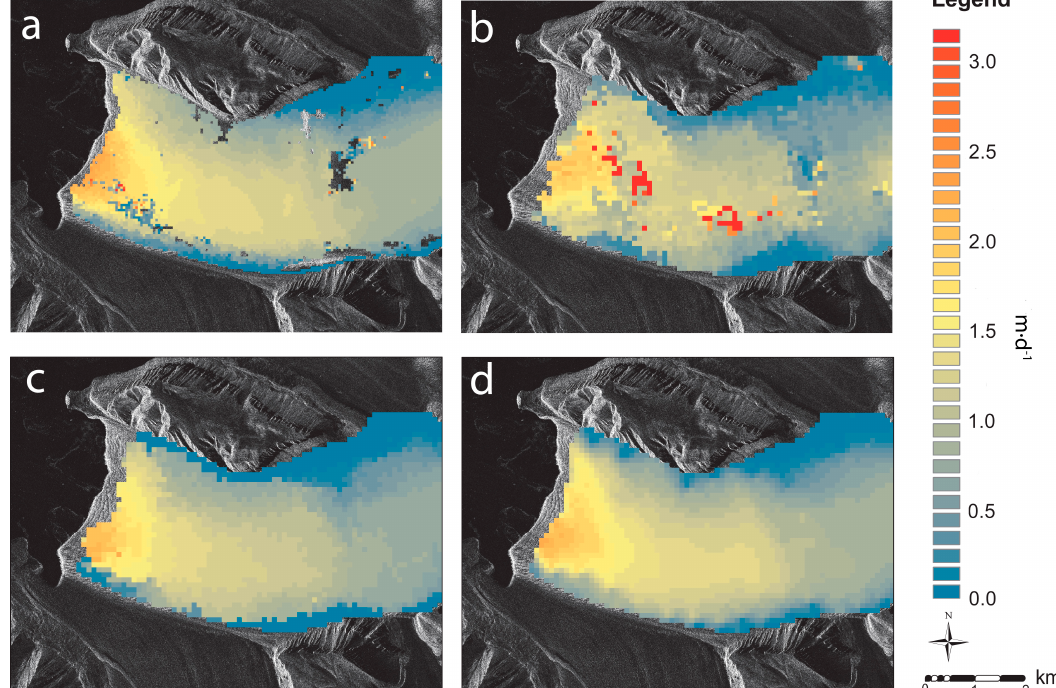
Figure 9. Surface speed of Kronebreen based on: ( a ) RS-2 UF data (3 January 2013–20 February 2013)